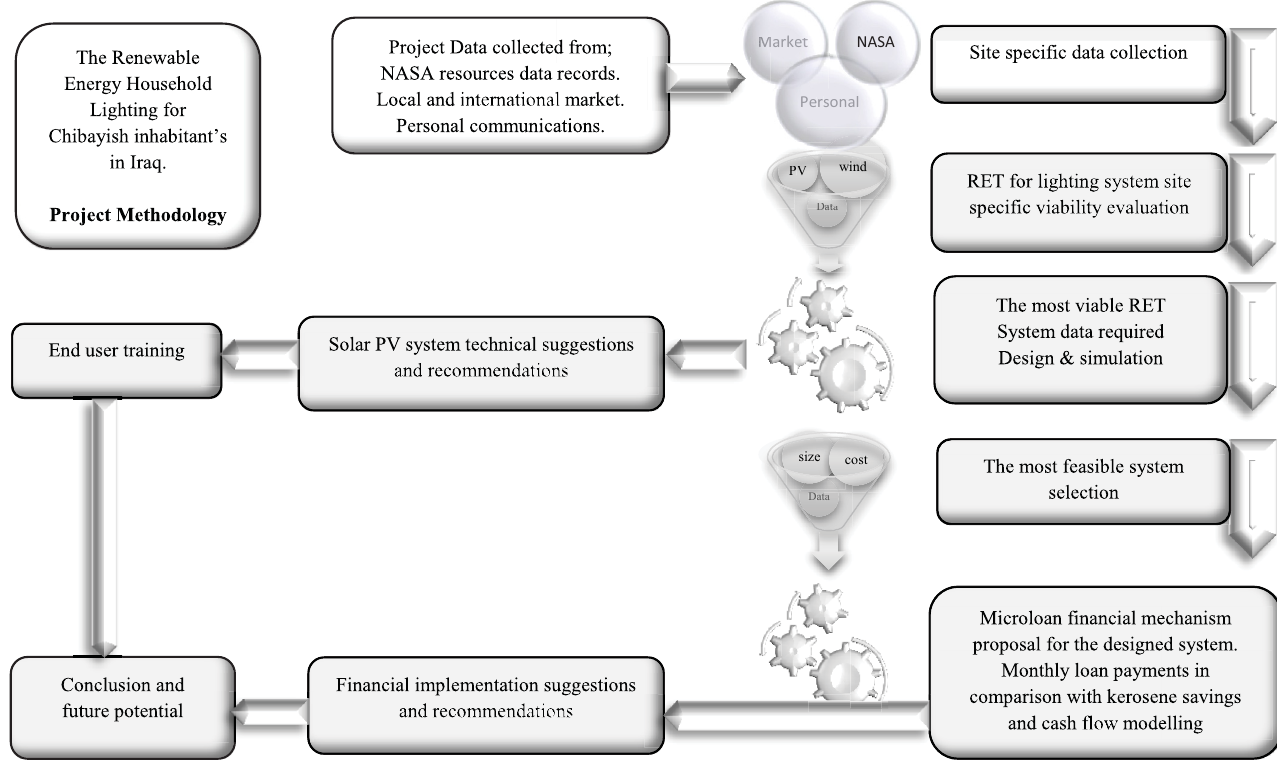
Fig. 3. Project methodology fl ow chart.